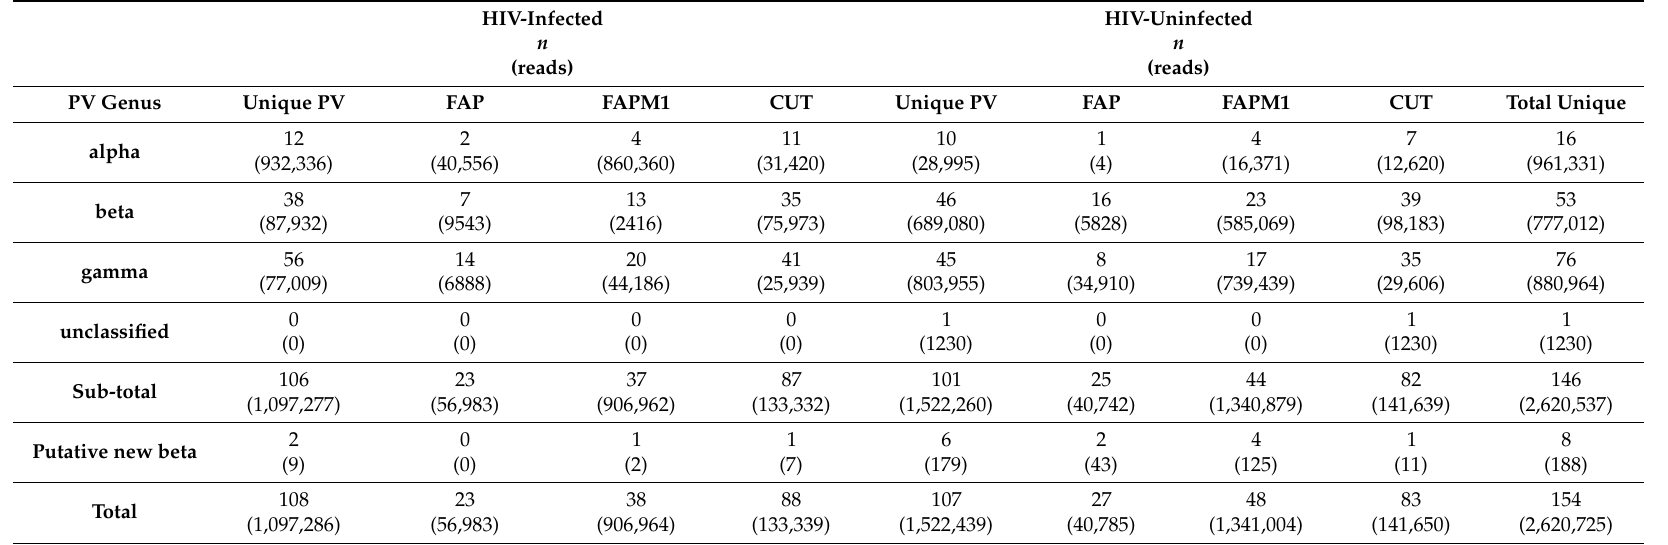
Table 5. Known and putative novel PV sequences in HIV-infected and HIV-uninfected samples. The number of sequences and corresponding reads are reported for alpha, beta, gamma, and unclassified PVs, stratified according to the primer set, by Randomized Axelerated Maximum Likelihood-evolutionary placement algorithm (RAxML-EPA) taxonomic classification according to HIV